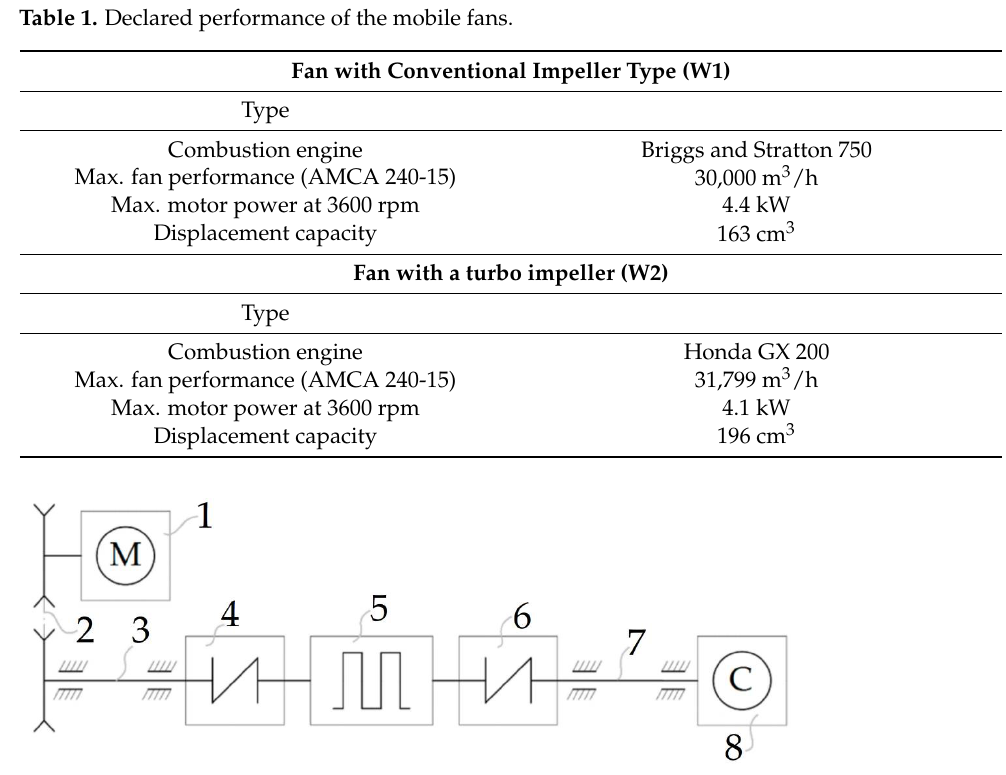
Figure 2. Schematic of the test station: 1, tested engine; 2, belt transmission (ratio 1:1); 3 and 7, inter- mediate shaft; 4 and 6, flexible coupling; 5, torque and rotational speed sensors; 8, fan